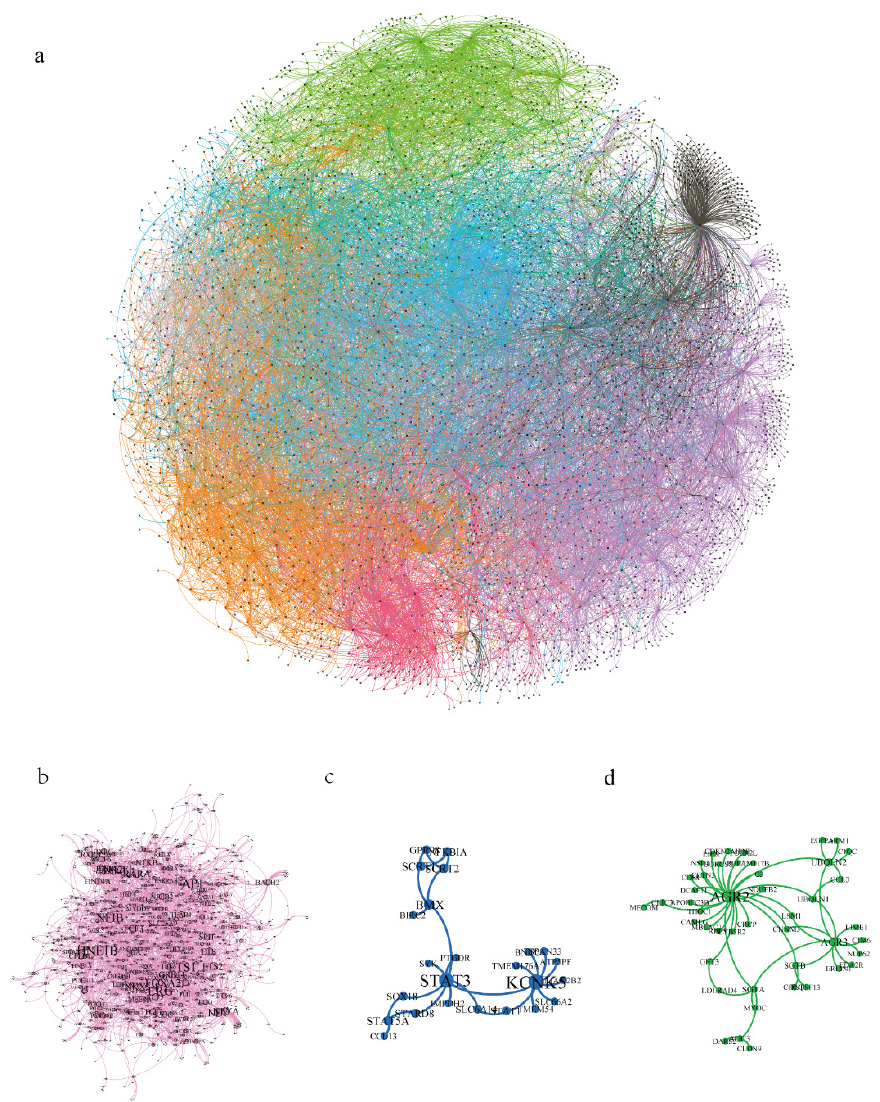
Figure 5. ( a ) The lung-specific background network. The different colors represented different modules. ( b – d ) The 3 COVID-19-related gene modules. Module red contains 903 genes, module blue contains 24 genes, and module green contains 46 genes. The size of the nodes is correlated with their degree centrality in the network.